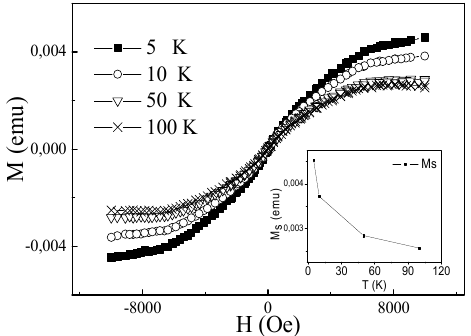
Figure 28. Hysteresis loop for the Cu 63 Fe 37 as-prepared sample at different temperatures with ρ = 0.063. Evolution of magnetization at maximum applied field is shown at the inset. Reproduced from reference [92], Figure 3b.